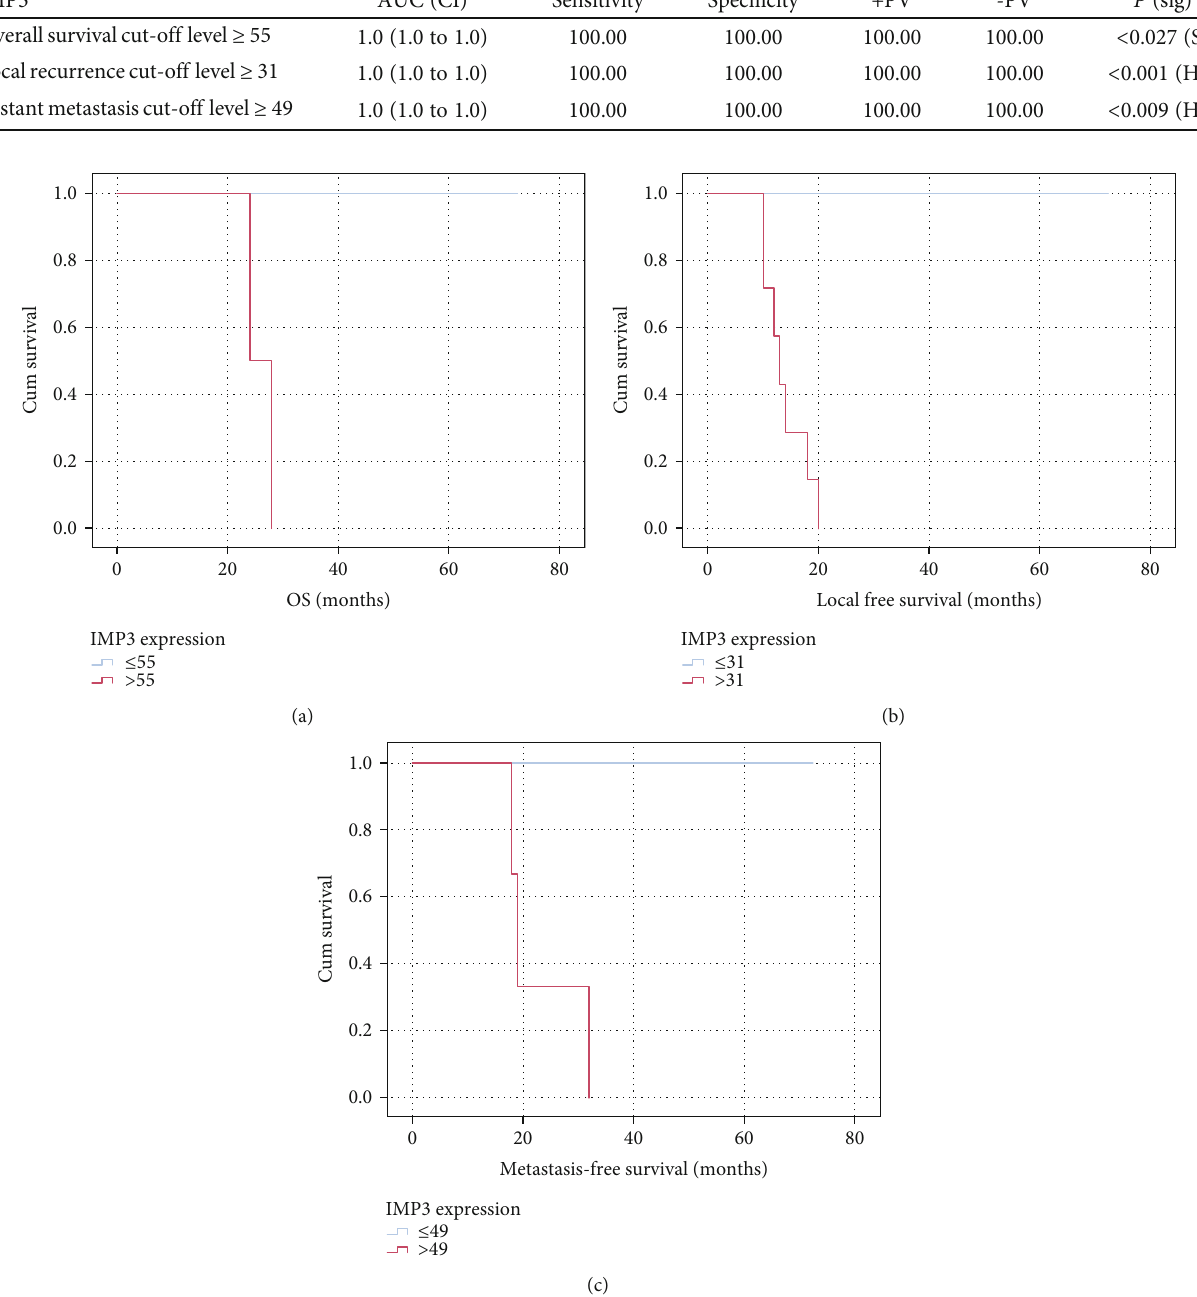
Figure 5: (a) Kaplan-Meier analysis showing correlation between IMP3 IHC expression and OS at a cut ‐ off level>55 ; (b) Kaplan-Meier analysis showing correlation between IMP3 IHC expression and local recurrence-free at a cut ‐ off level >31 ; (c) Kaplan-Meier analysis showing correlation between IMP3 IHC expression and distant metastasis at a cut ‐ off level >49